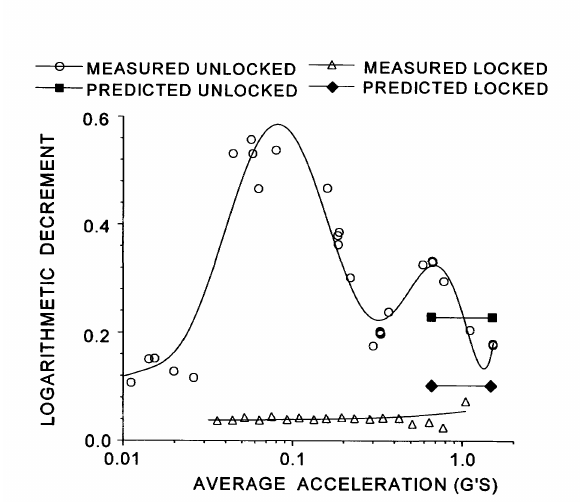
FIGURE 12 Comparison of measured to predicted values for three bay